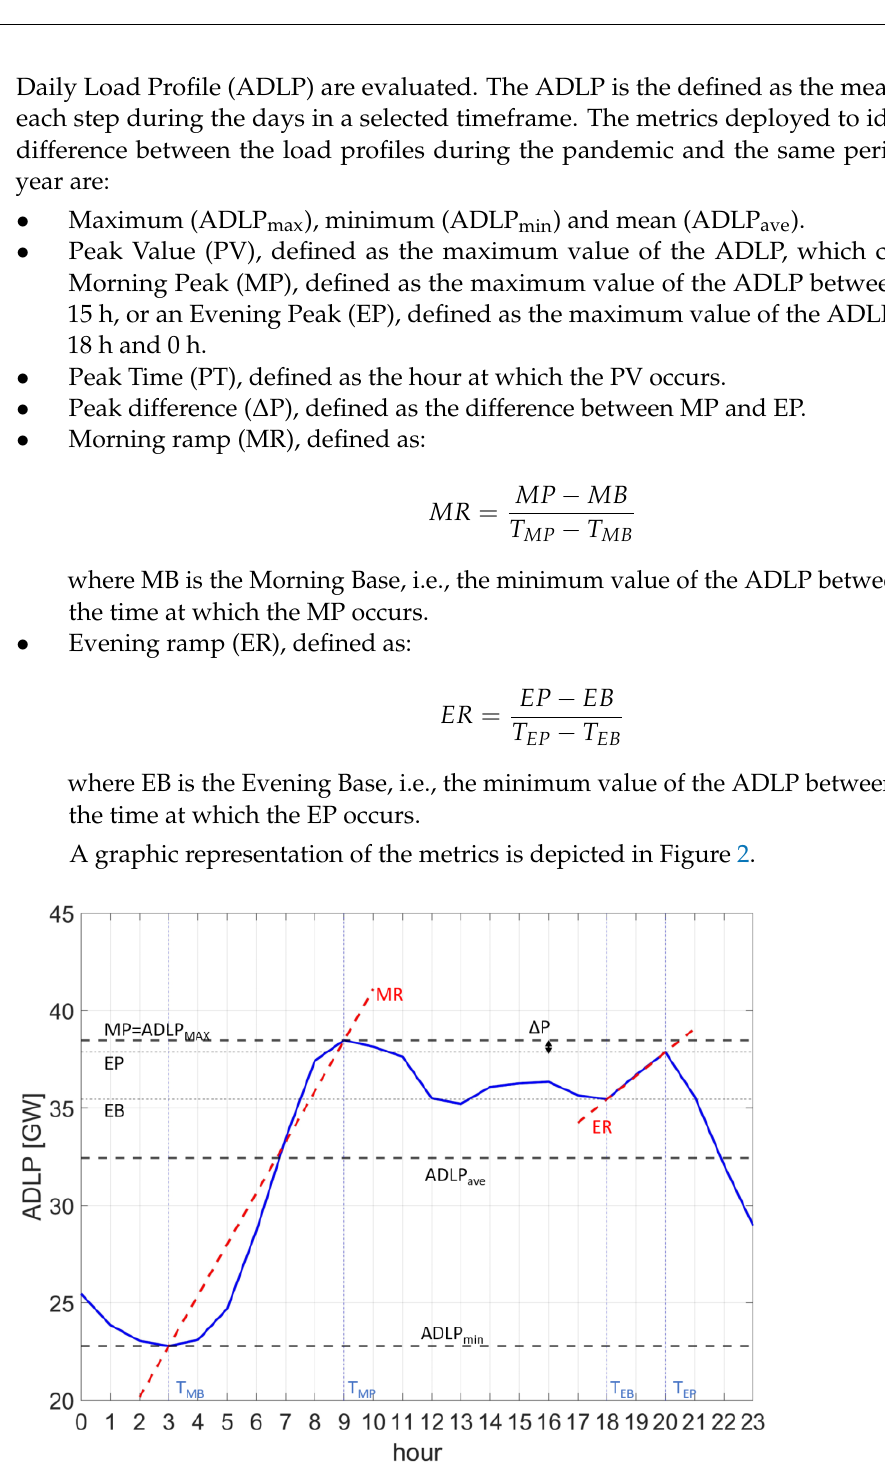
Figure 2. Average daily load profile (ADLP)